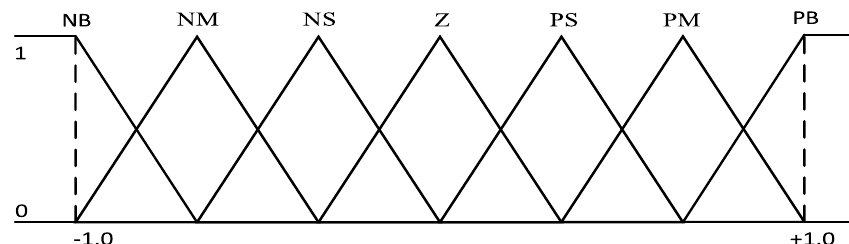
Fig. 8 The membership function of e , ec